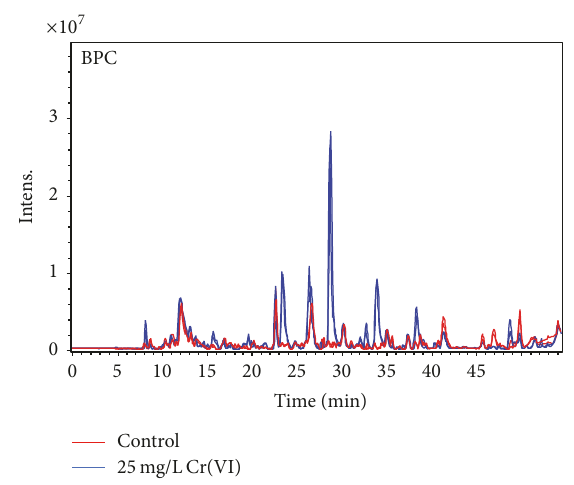
Figure 2: Base peak chromatograms obtained for the root extracts of Cr(VI) exposed plants (blue) and for control, nonexposed plants